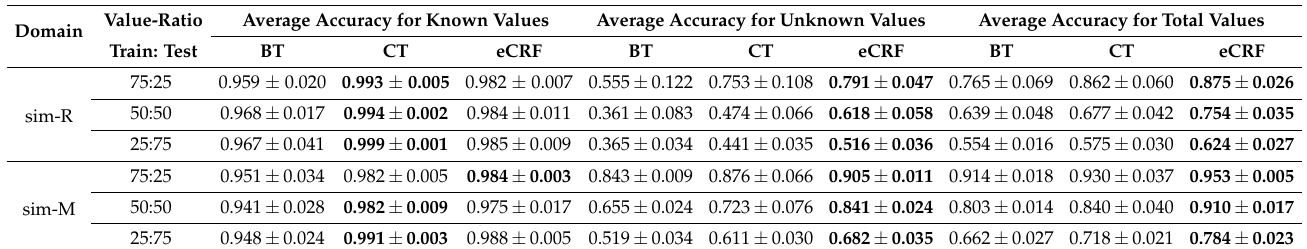
Table 1. Results for the in-domain tasks: average exact matching accuracies for known values, unknown values and total values for three models. Models are BiLISM tagging (BT) model, concept tagging (CT) model [12] and elastic CRF (eCRF). Sim-R and sim-M are the domains of restaurant and movie respectively. For each domain, three ratios between the number of types of values in training and testing are chosen to re-split the whole dataset to train models. Bold numbers mean the best results among three compared models.